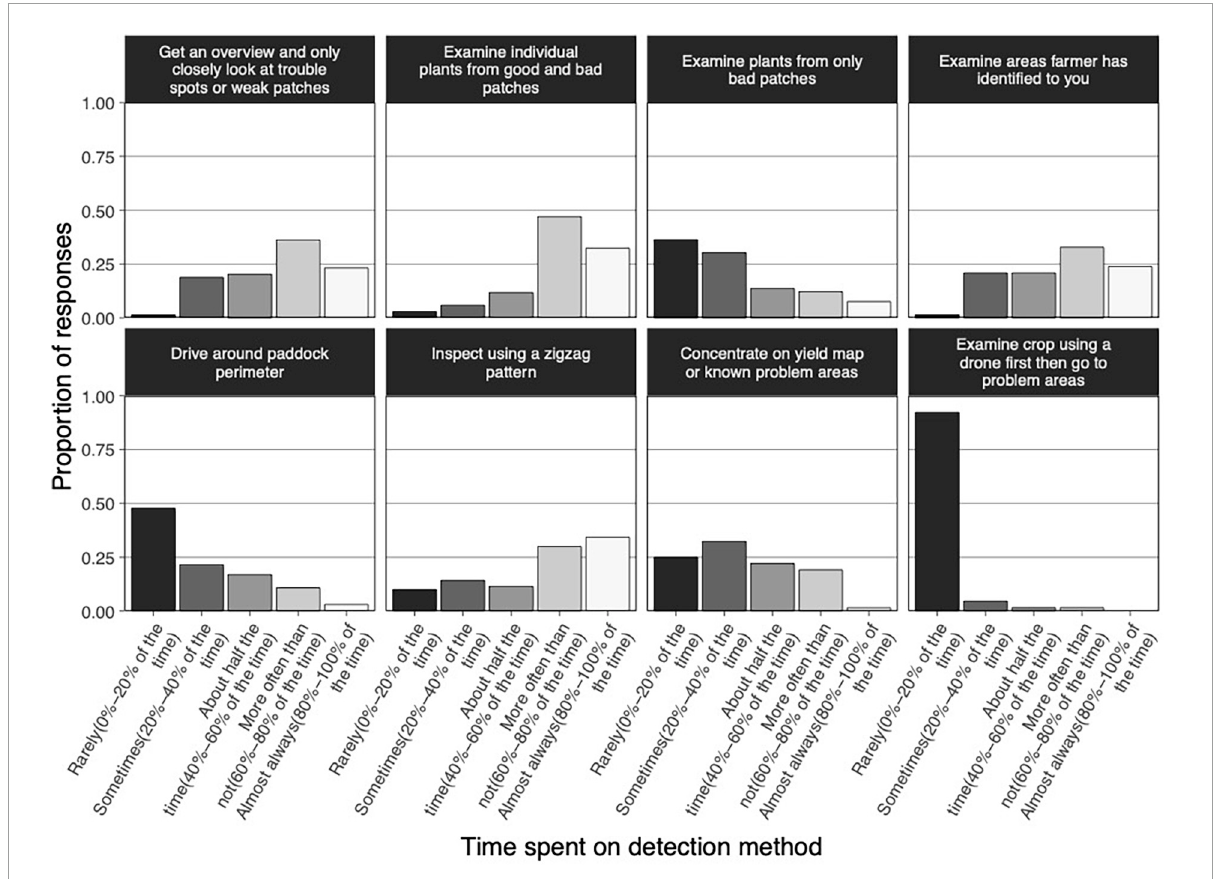
FIGURE2 Proportion of time spent by agronomists on eight different crop inspection methods. Vertical bars represent the proportion of responses. Bar gray scaling indicates differences in frequency of method application, ranging from “rarely” to “almost